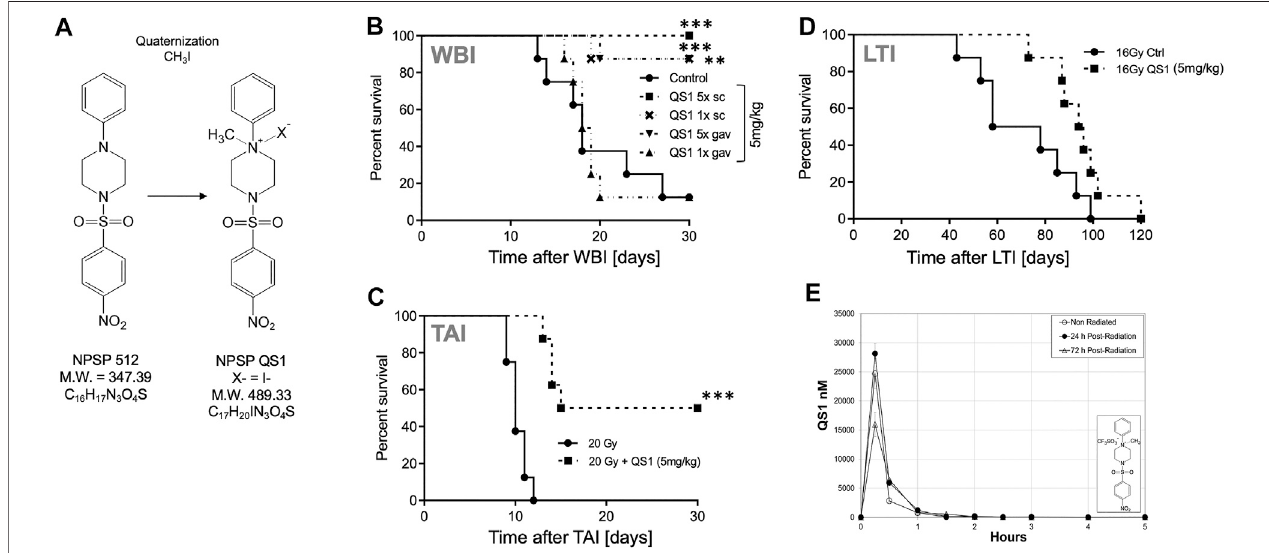
FIGURE 3 | (A) Quaternization of NPSP512 to yield QS1. (B) QS1 at 5 mg/kg mitigates H-ARS lethality in C3H male mice after LD70/30 WBI ( p < 0.0001; Cs source; 7.725 Gy)if given 5 × dailybys.c., or gavage,or 1 × ifgiven s.c., ( p (cid:2) 0.0023), but not bygavage. (C) QS1at 5 mg/kg, 5X daily s.c., mitigatesGI-ARS after 20 Gy total abdominal irradiation in C57BL/6 male mice and (D) radiation pneumonitis in C3H mice after 16 Gy local thoracic irradiation. (E) PK parameters for 10 mg/kg QS1 injected s.c., assessed when drug is given 24 or 72 h after WBI showing a decrease in plasma concentration if given at 72 h. * (cid:2) p < 0.05, ** p < 0.01, *** p <